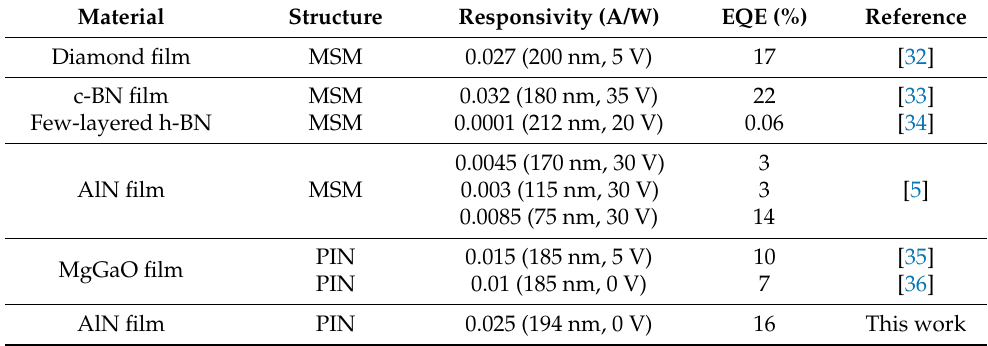
Figure 4. ( a ) The I − V characteristic curve of the FUV PDs under dark conditions and 185 nm light of 30.6 μW/cm 2 . The current value is treated as an absolute value. ( b ) Spectral responsivity (R λ ) curves of devices illuminated by monochromatic light with different wavelengths. The inset is the R λ −λ curve in logarithmic coordinates. ( c ) Photocurrent switching characteristic curve of the device under varying power light excitation at 0 V bias. ( d ) The I ph − t curves of the device under varying bias voltage with the same incident light power of 40.8 μW/cm 2 . Table 1. Comparisons of UWBSs-based FUV